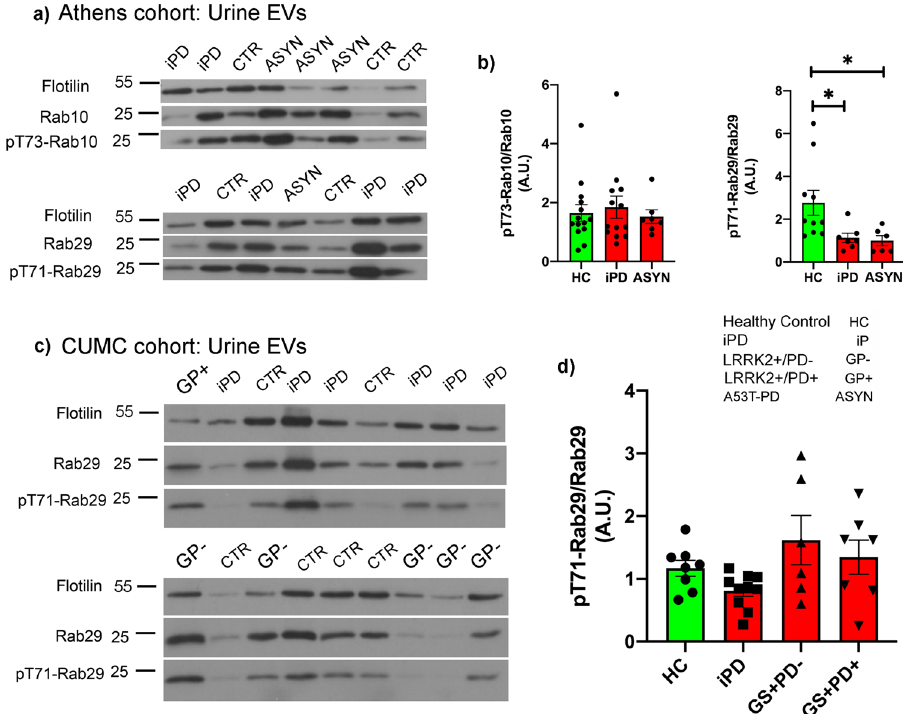
Fig. 2 Phosphorylation of Rab10 is unaffected in urinary EVs but phosphorylation of Rab29 is decreased in two PD cohorts. EVs from urine were puri fi ed by ultracentrifugation, and extracts separated by SDS-PAGE. The membranes were probed with total or phosphorylated Rab10 and 29, and fl otilin as a marker for EVs. Band intensities of phosphorylated Rab10 or Rab29 were normalized to total Rab. a , c Representative blots showing phosphorylated Rab10 and Rab29; and quanti fi ed in ( c , d ). Error bars in all data plots represent SEM. ANOVA was performed to identify signi fi cant differences between groups, with Tukey ’ s post-hoc tests. * p <